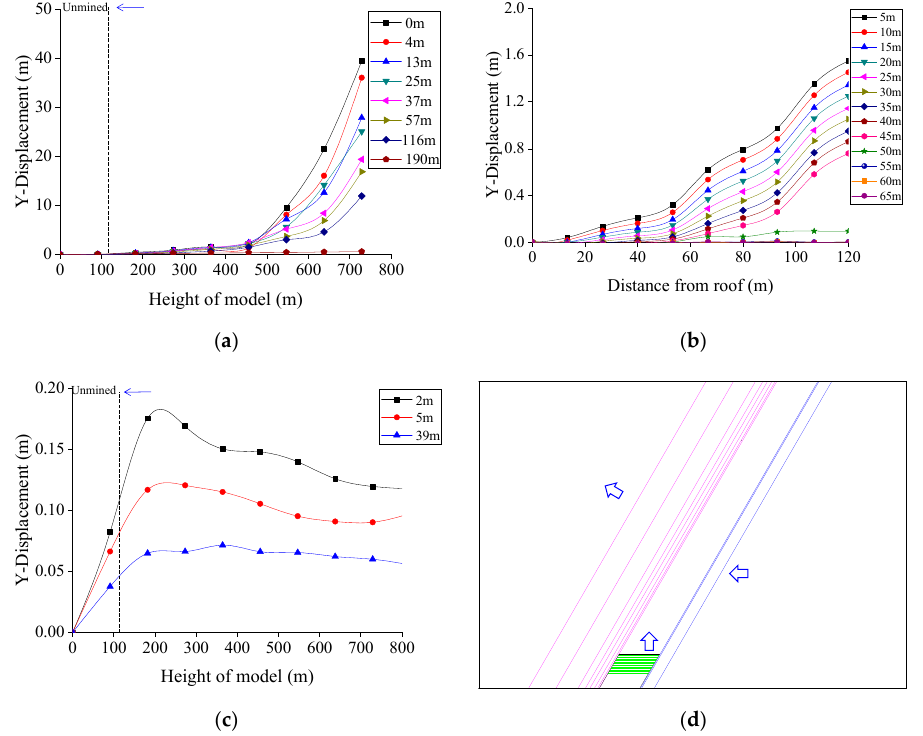
Figure 9. Simulated displacements in the roof, bottom coal, and floor: ( a ) Displacement in the roof; ( b ) displacement in bottom coal; ( c ) displacement in the floor; and ( d ) measuring lines in the model.